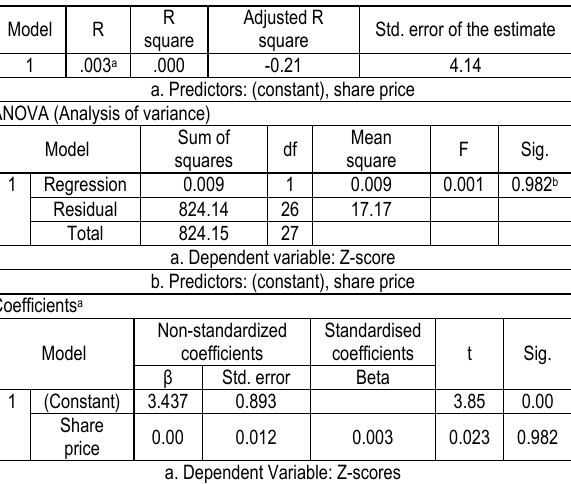
Table 3. Regression and ANOVA of Z-scores on market